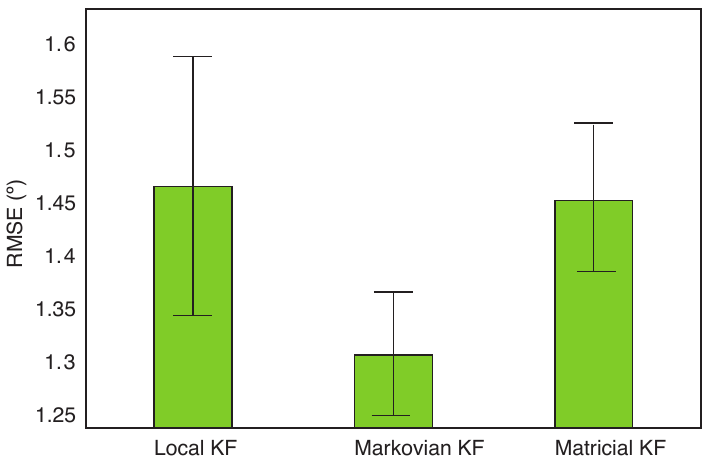
Figure 7. Main effect of the applied Kalman filter. The bars represent the 95% confidence intervals.